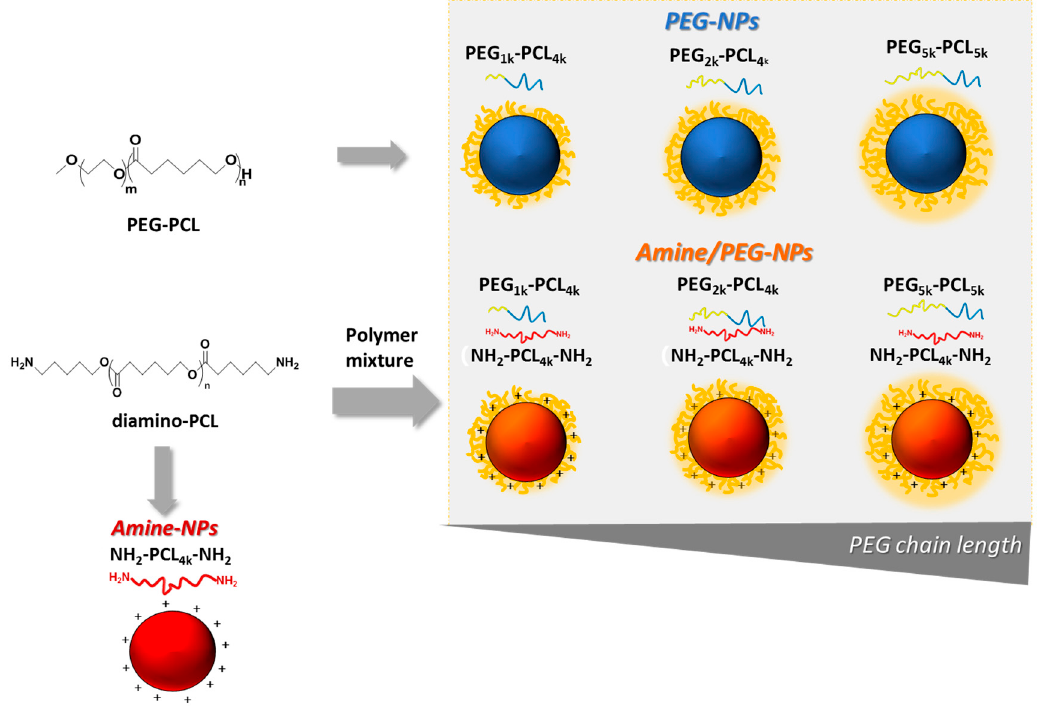
Figure 2. Schematic representation of nanoparticles tested in the study.